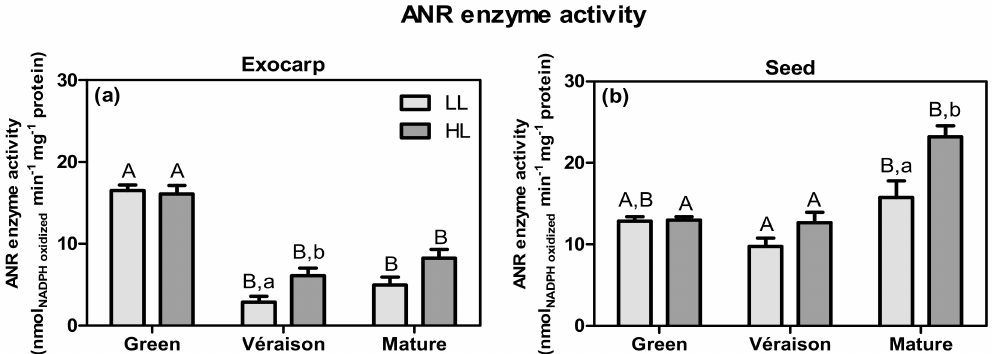
Figure 8. Anthocyanidin reductase (ANR; EC 1.3.1.77) biochemical activity, expressed in V max (nmol NADPH oxidized min − 1 mg − 1 protein) in exocarp ( a ) and seeds ( b ), from berries grown at two distinct light microclimates (LL and HL) and at three developmental stages (green, v é raison and mature). Statistical analysis (two-way ANOVA, p ≤ 0.05, n = 4–8) was applied. Statistical notation: capital letters refer to differences between developmental stages for the same microclimate, and lowercase letters refer to differences between microclimates for each stage. When the letters are omitted, it means that the respective factor did not have a significant